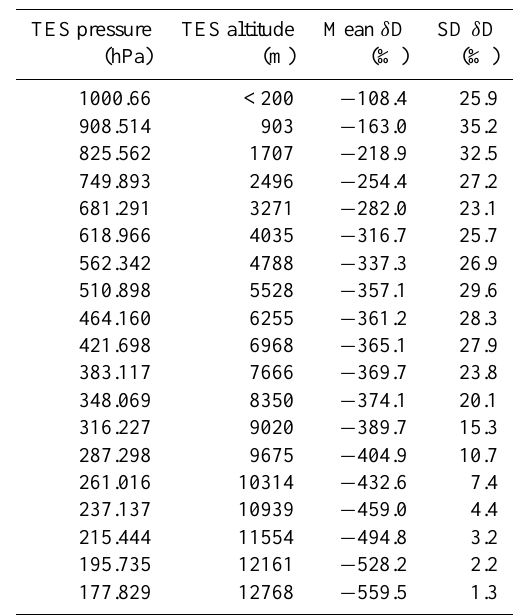
Table 3. Aura TES statistics of atmospheric water vapor δ D vari- ability over the Alaskan interior boreal forest. Twenty-seven TES transect special observations from July to August 2011 and July to August 2012 are binned together by pressure level (DOFS>1.1) for mean δ D and standard deviation of δ D. Bias correction has been applied to these measurements (Sect. 4.3).